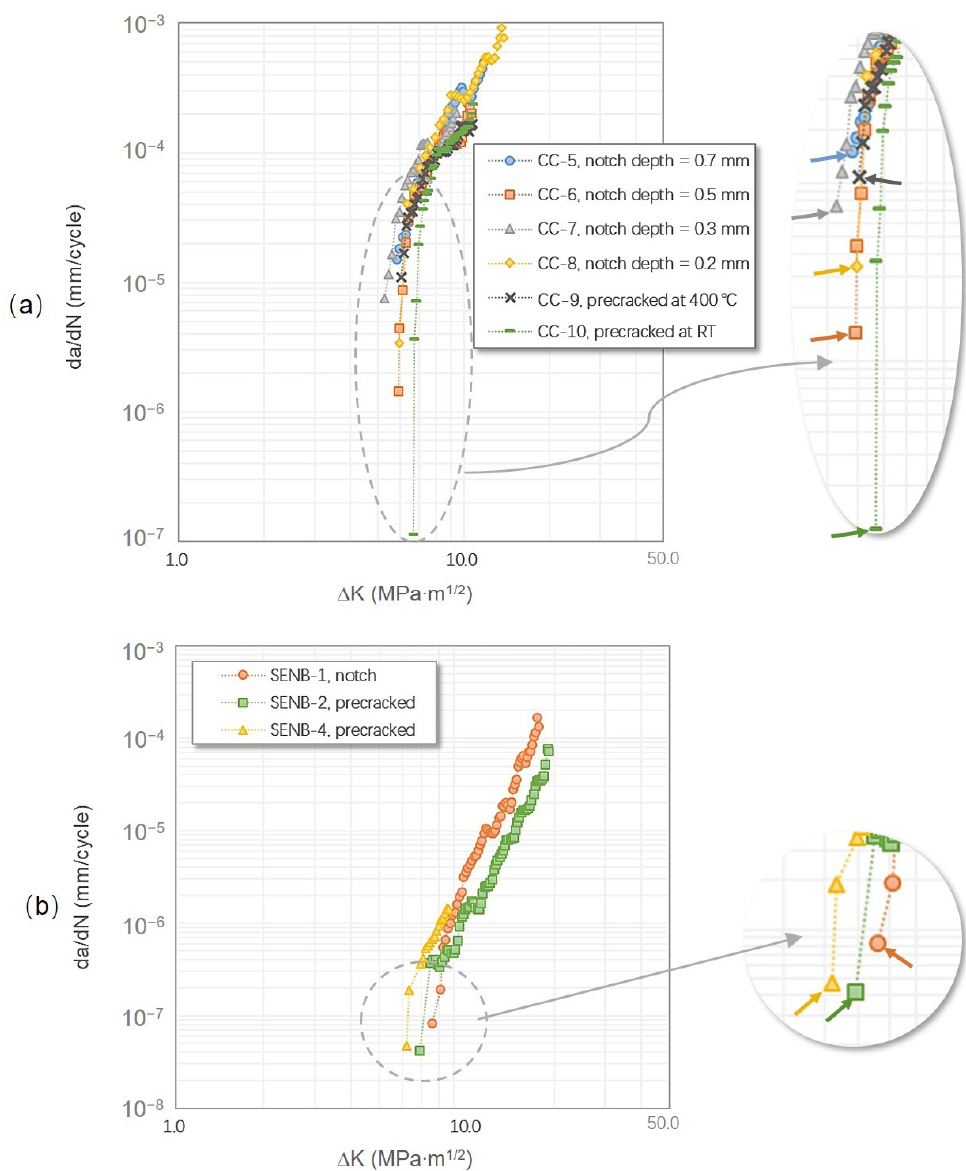
Figure 7. Comparison of the FCG curves of specimens with and without precrack. All the tests were carried out using the load-increasing method: ( a ) the test conducted in the CC specimens at 650 °C and R = 0.1, of which two specimens were precracked at RT and 400 °C and then tested, and ( b ) the tests conducted in the SENB specimens at RT and R = 0.1.